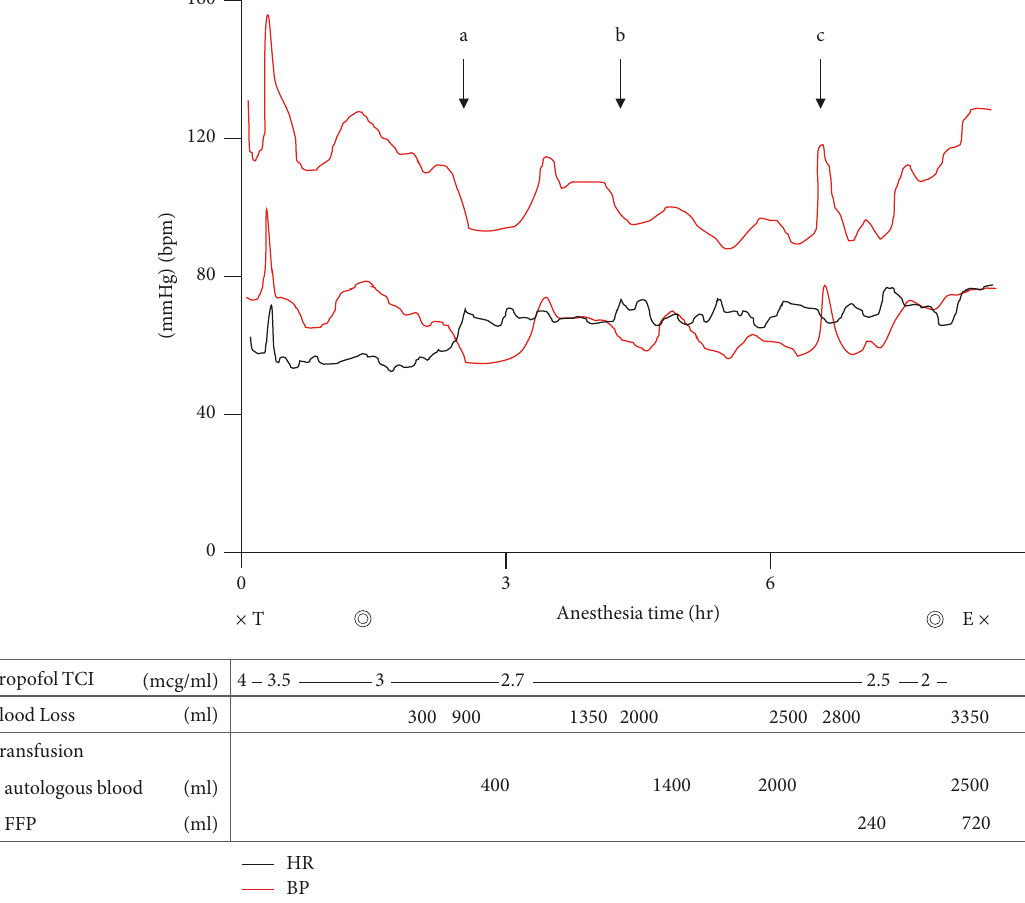
Figure 1: Anesthetic record. The black line indicates heart rate (HR) and the red lines indicate blood pressure (BP). a: six hundred mL of blood loss within 20 minutes, b: six hundred and fifty mL of blood loss within 30 minutes, c: administration of 0.1 mg phenylephrine, × : start or end of anesthesia, (cid:2) : start or end of the surgery, T: tracheal intubation, E: extubation, TCI: target-controlled infusion, and FFP: fresh frozen